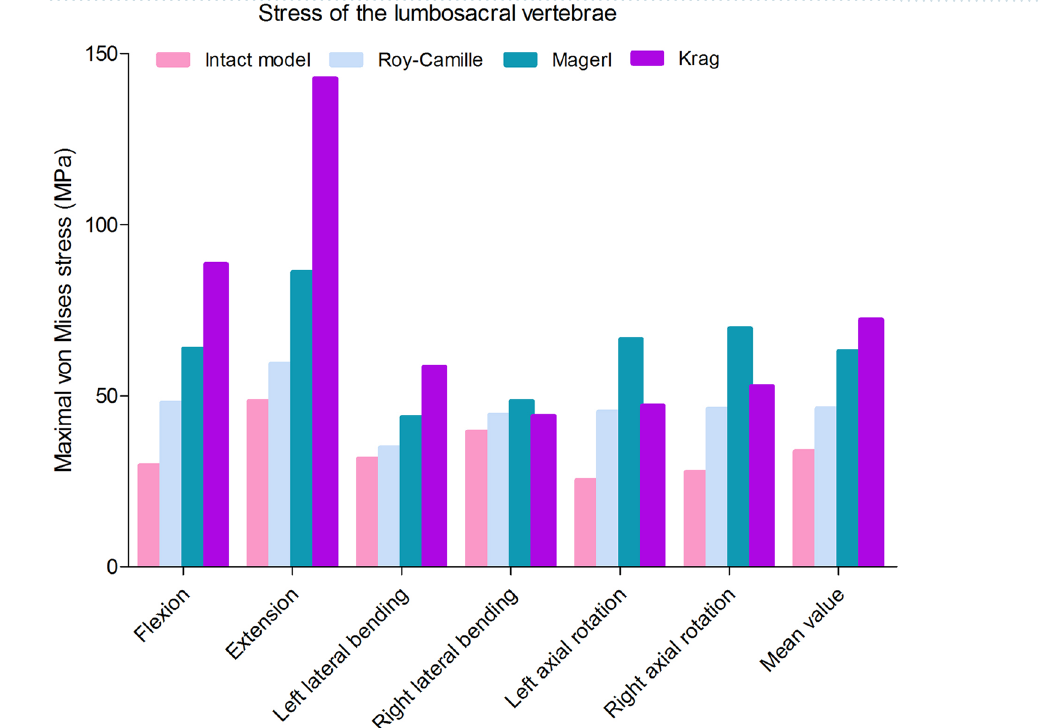
Figure 7. The von Mises stress of the lumbosacral vertebrae in different FE